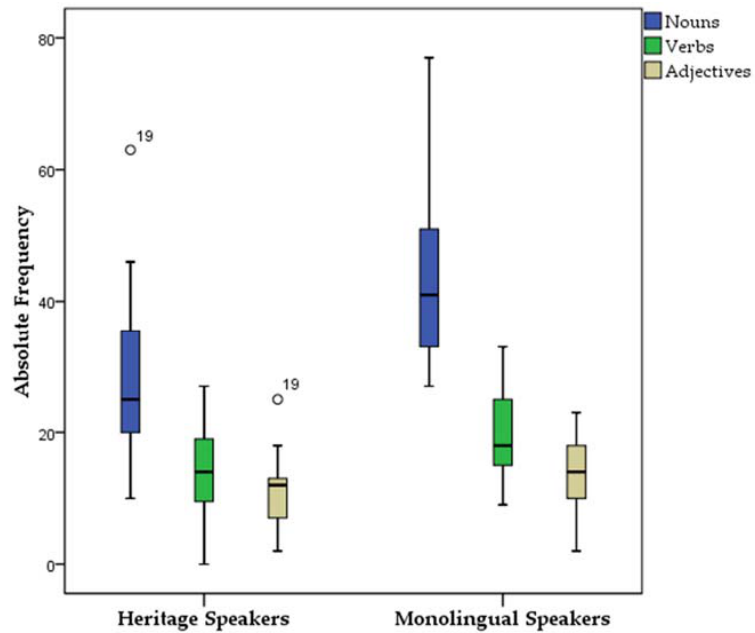
Figure 3. Boxplot: Lexical distribution and variation per group of EP speakers regarding the subcorpora. Table 1. Lexical distribution and variation per group of European Portuguese (EP) speakers regarding the subcorpora.